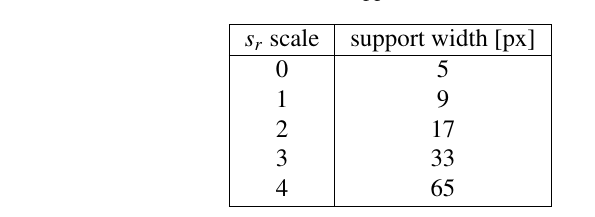
Table 1. support vs. s r